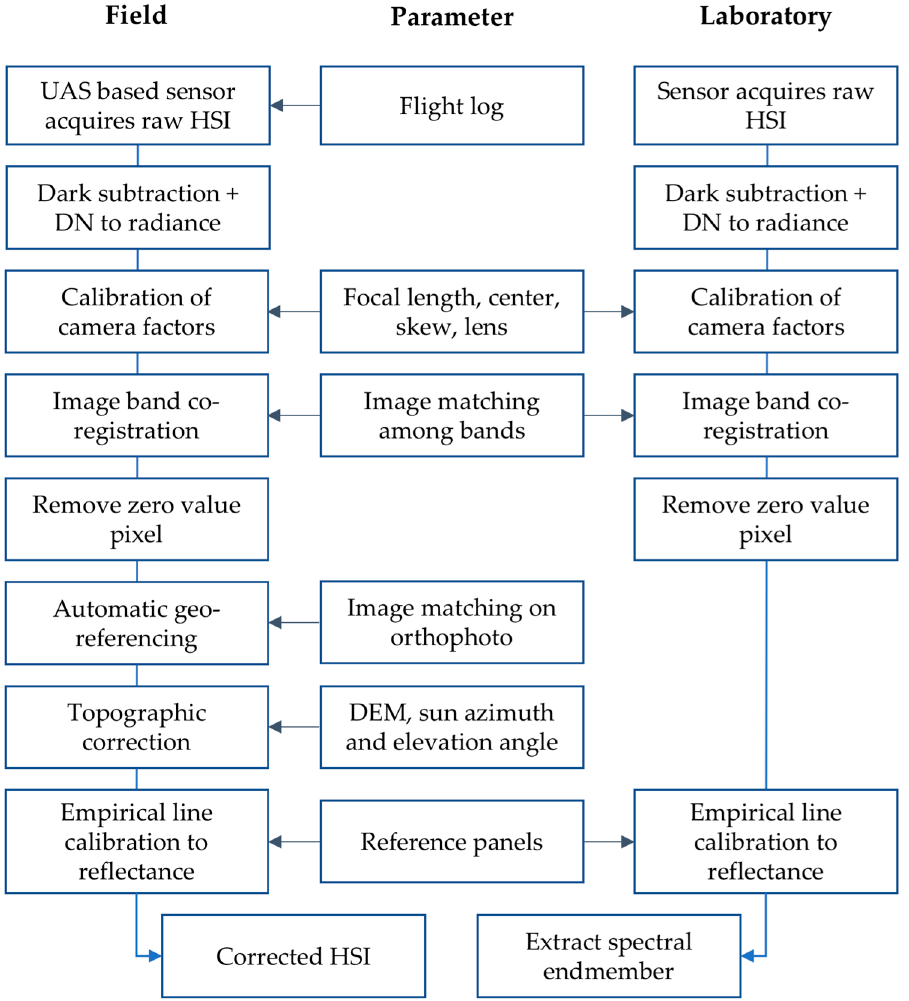
Figure 4. Flowchart showing single processing steps for HSI data.